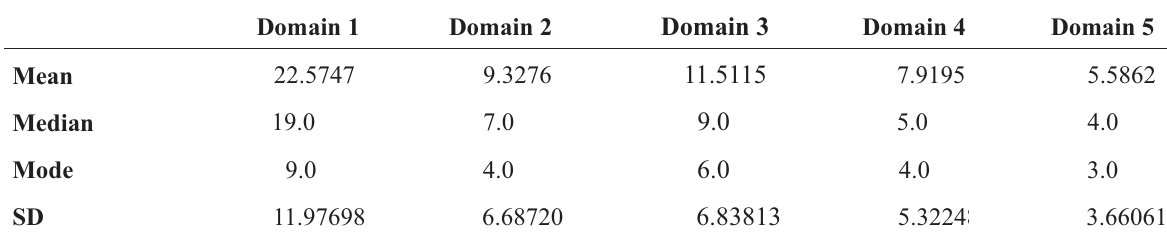
Table 4: Distribution of menopause specific quality of life scores according to domains in MENQOL-S